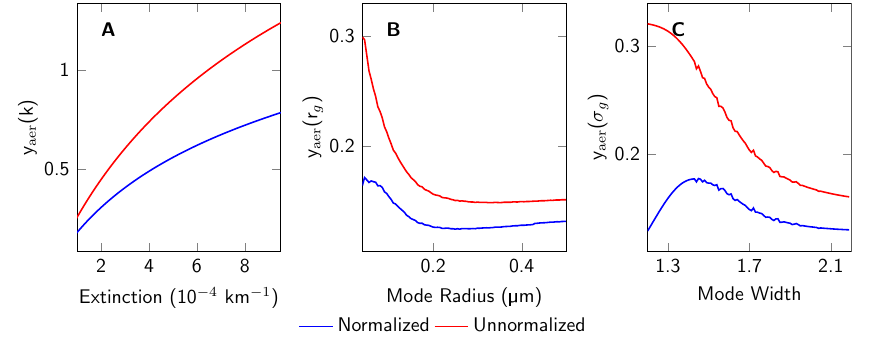
Fig. 3. Response of the normalized (blue) and un-normalized (red) measurement vectors at 25km to changes in aerosol parameters for a scan with a solar zenith angle of 70 ◦ and solar scattering angle of 90 ◦ . (A) shows the measurement vectors as a function of extinction with a mode radius of 80nm and mode width of 1.6. (B) shows the response as a function of mode radius given a mode width of 1.6 and extinction of 1e-4km − 1 . (C) shows the response as a function of mode width given a mode radius of 80nm and extinction of 1e-4km − 1 .